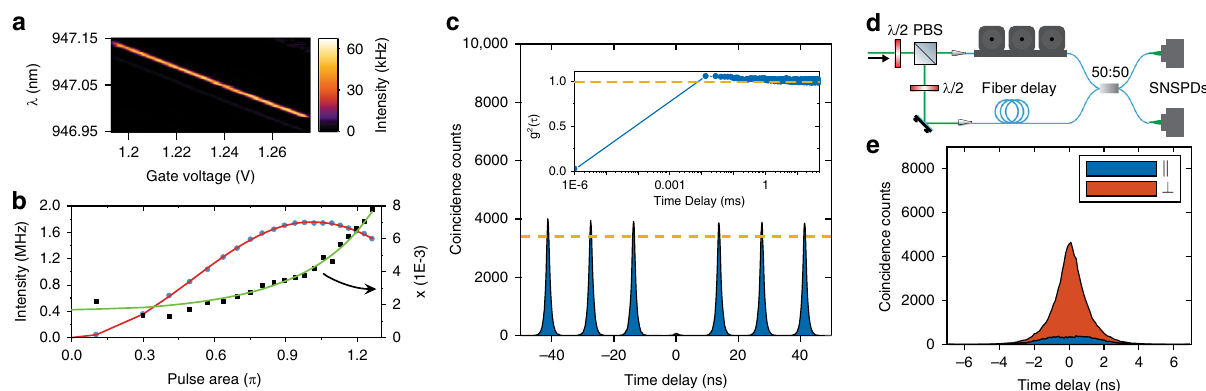
Fig. 3 Demonstration of pure and indistinguishable single photons by pulsed deterministic resonant excitation. a QD resonance- fl uorescence intensity under cw laser excitation at a power of P = 0.01 ⋅ P s at , where P s at is the saturation power. b Power dependence of the resonance- fl uorescence intensity and the photon impurity ξ . The Rabi oscillations (red curve) of the two-level system are modeled including a pure dephasing rate of γ d = 0.2 ns − 1 . c The intensity-correlation histogram in a Hanbury Brown and Twiss experiment for π − pulse excitation. The second-order correlation function g (2) (0) = 0.02 ± 0.005 is extracted from the fi tted amplitude of the central peak relative to the fi tted amplitude for peaks at a time delay of 50 μ s (dashed line). The inset shows g (2) ( τ ) measured by integrating the coincidences under the peak over the 50 μ s time span. d Schematic of the Hong – Ou – Mandel interferometer used for measuring the indistinguishability of two subsequent photons delayed by the laser pulse separation of 13.7 ns. e Coincidence counts after the Hong – Ou – Mandel interferometer when the input photons are co-polarized (blue) and cross-polarized